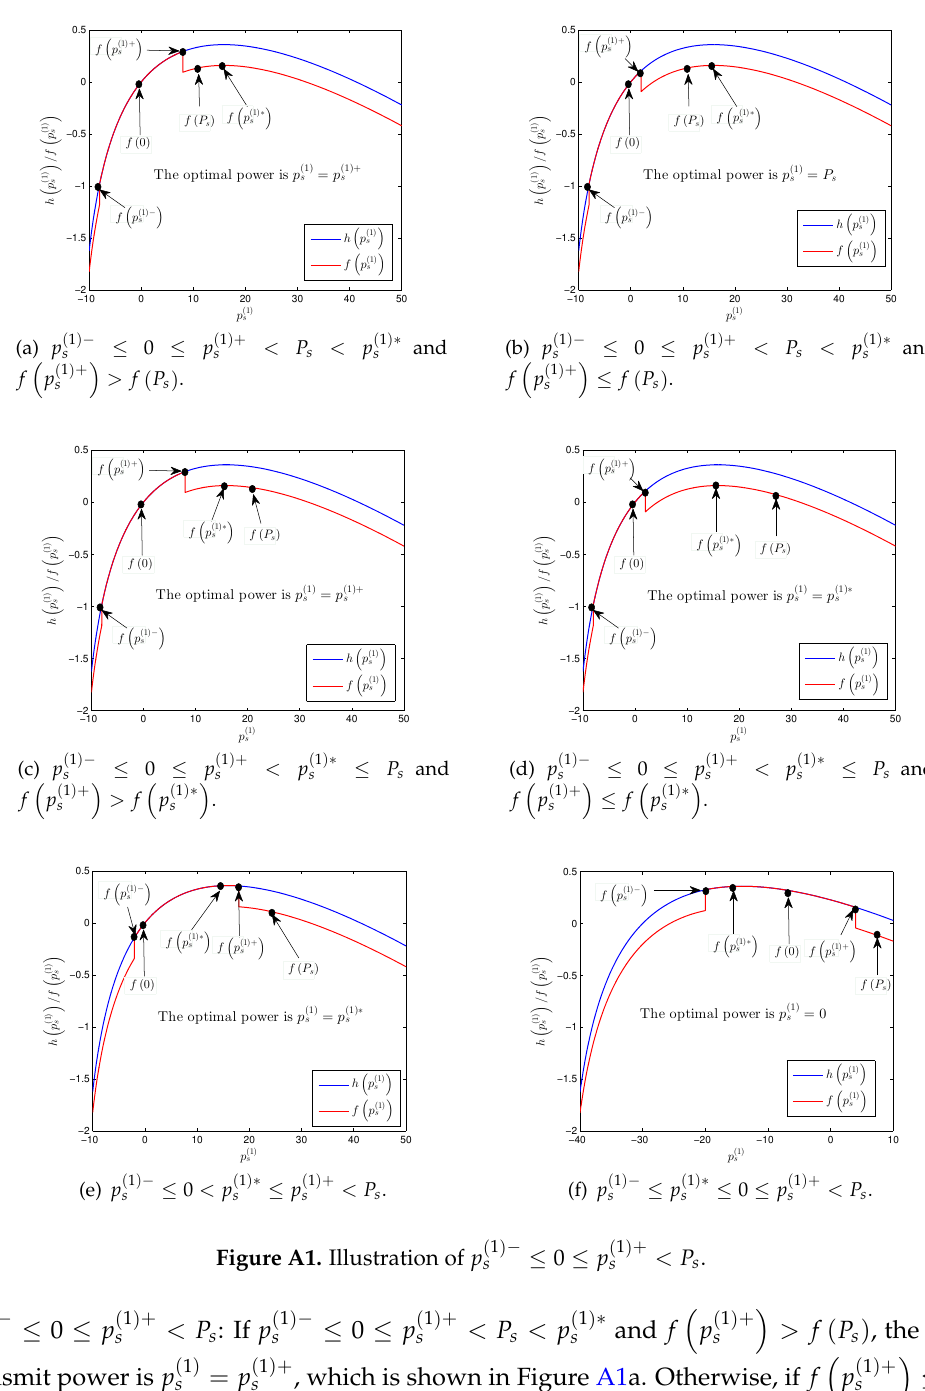
Figure A1. Illustration of p